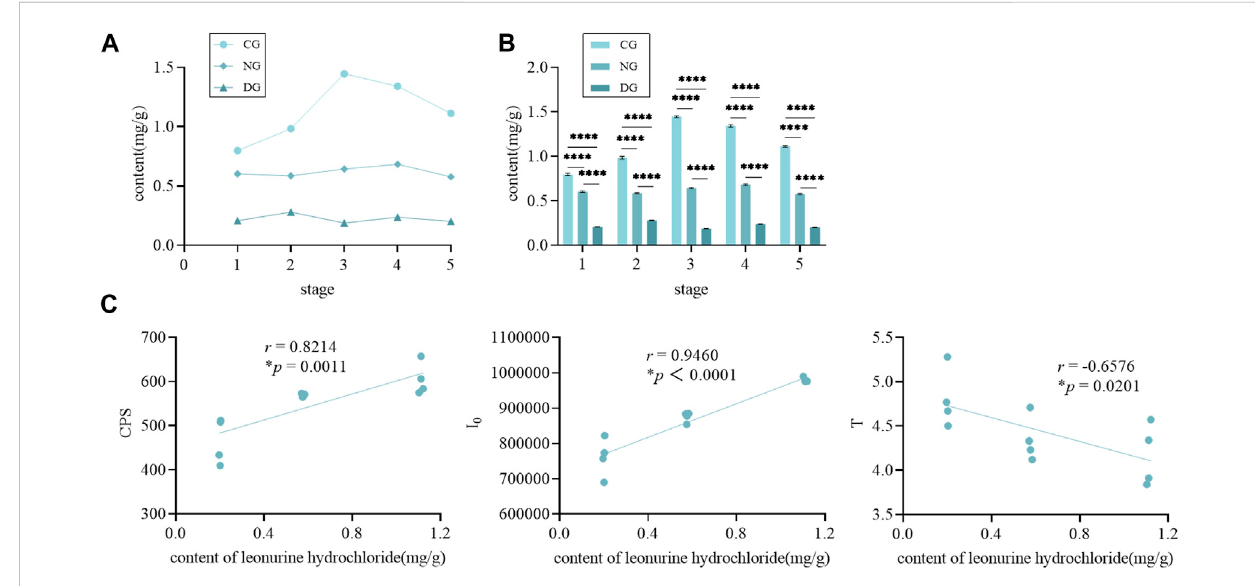
The UPLC and correlation analysis of motherwort. (A) The contentof leonurine hydrochloride in different groups during the growth of motherwort. (B) The t-test of leonurine hydrochloride content in different groups. (C) The correlation analysis between leonurine hydrochloride content and biophoton